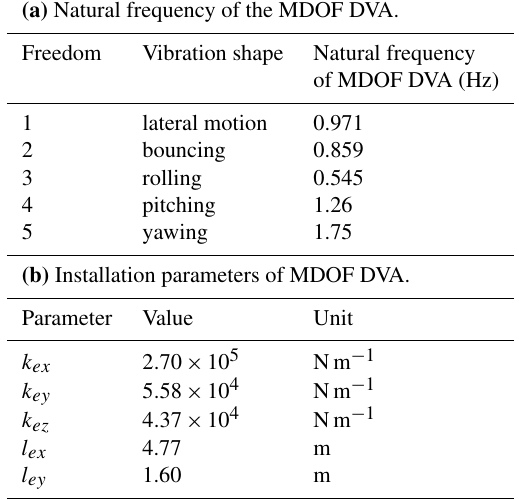
Table 2. Optimized parameters of MDOF DVA of the car body. (a) Natural frequency of the MDOF DVA.